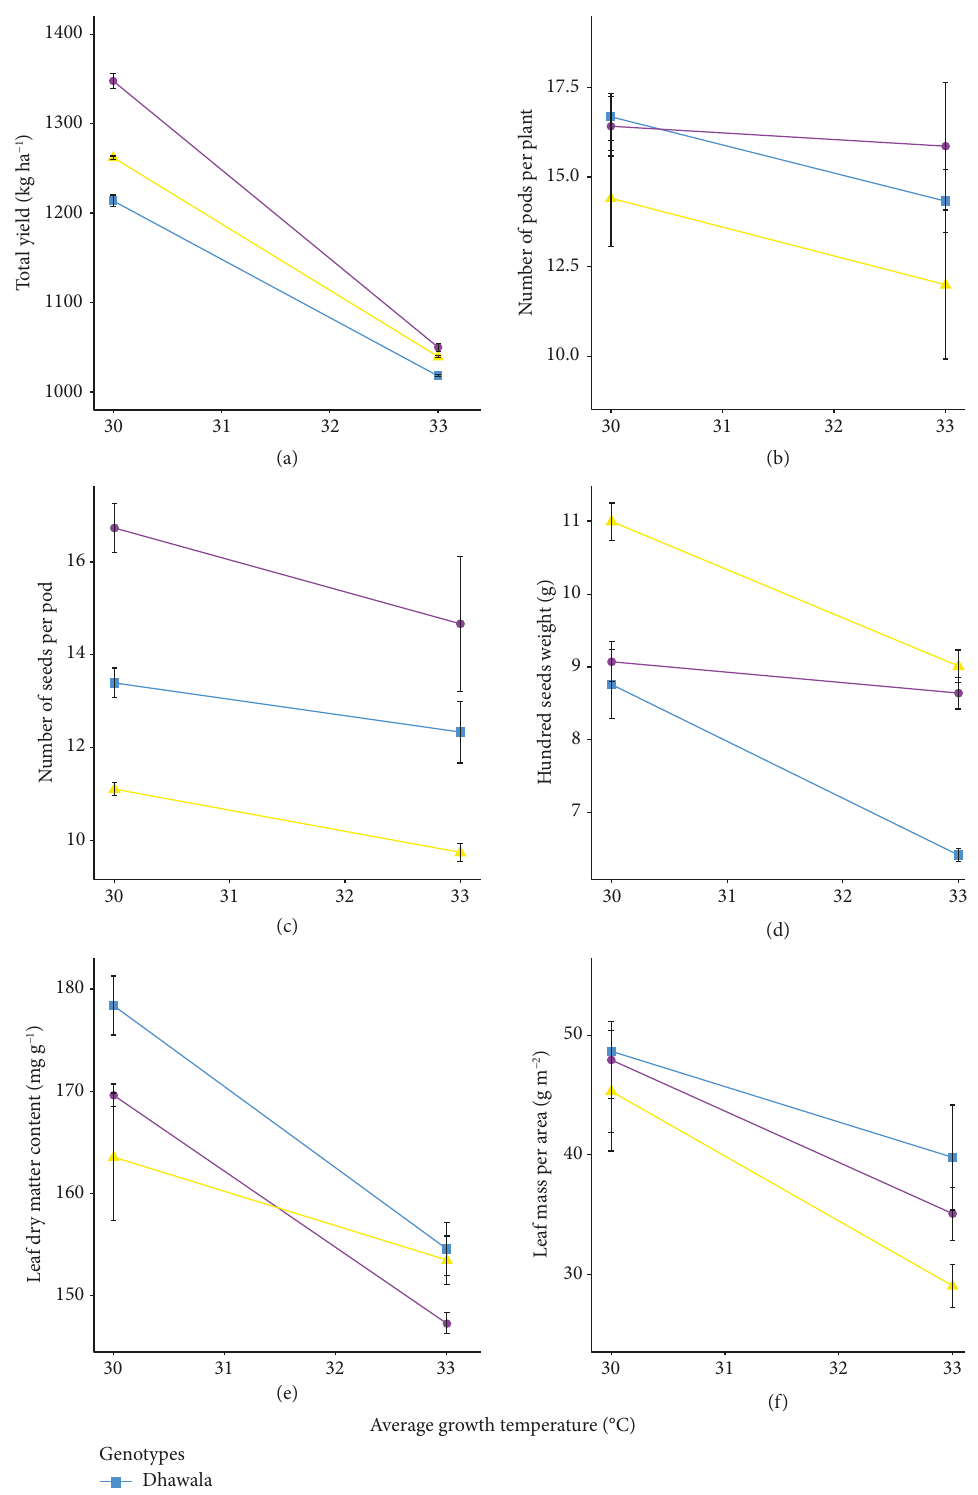
Figure 2: Yield components and leaf traits of three cowpea genotypes (square–Dhawala, circle–MI-35, and triangle–Waruni) grown at two growth temperatures, 30 ° C and 33 ° C, in Anuradhapura, Sri Lanka. The panels are (a) total yield (kg · ha − 1 ), (b) number of pods per plant, (c) number of seeds per pod, (d) hundred seed weight (g), (e) leaf dry matter content (g · g − 1 ), and (f) leaf mass per area (gm − 2 ). Whiskers around the points are the standard error of the